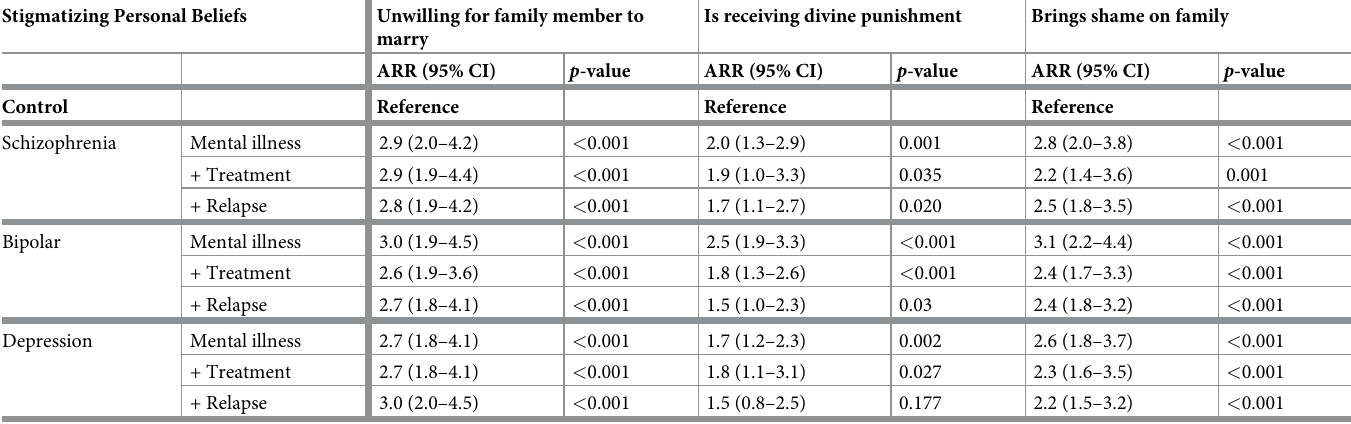
Table 4. Risk of stigmatizing personal beliefs by treatment assignment based on Poisson regression. Stigmatizing Personal Beliefs